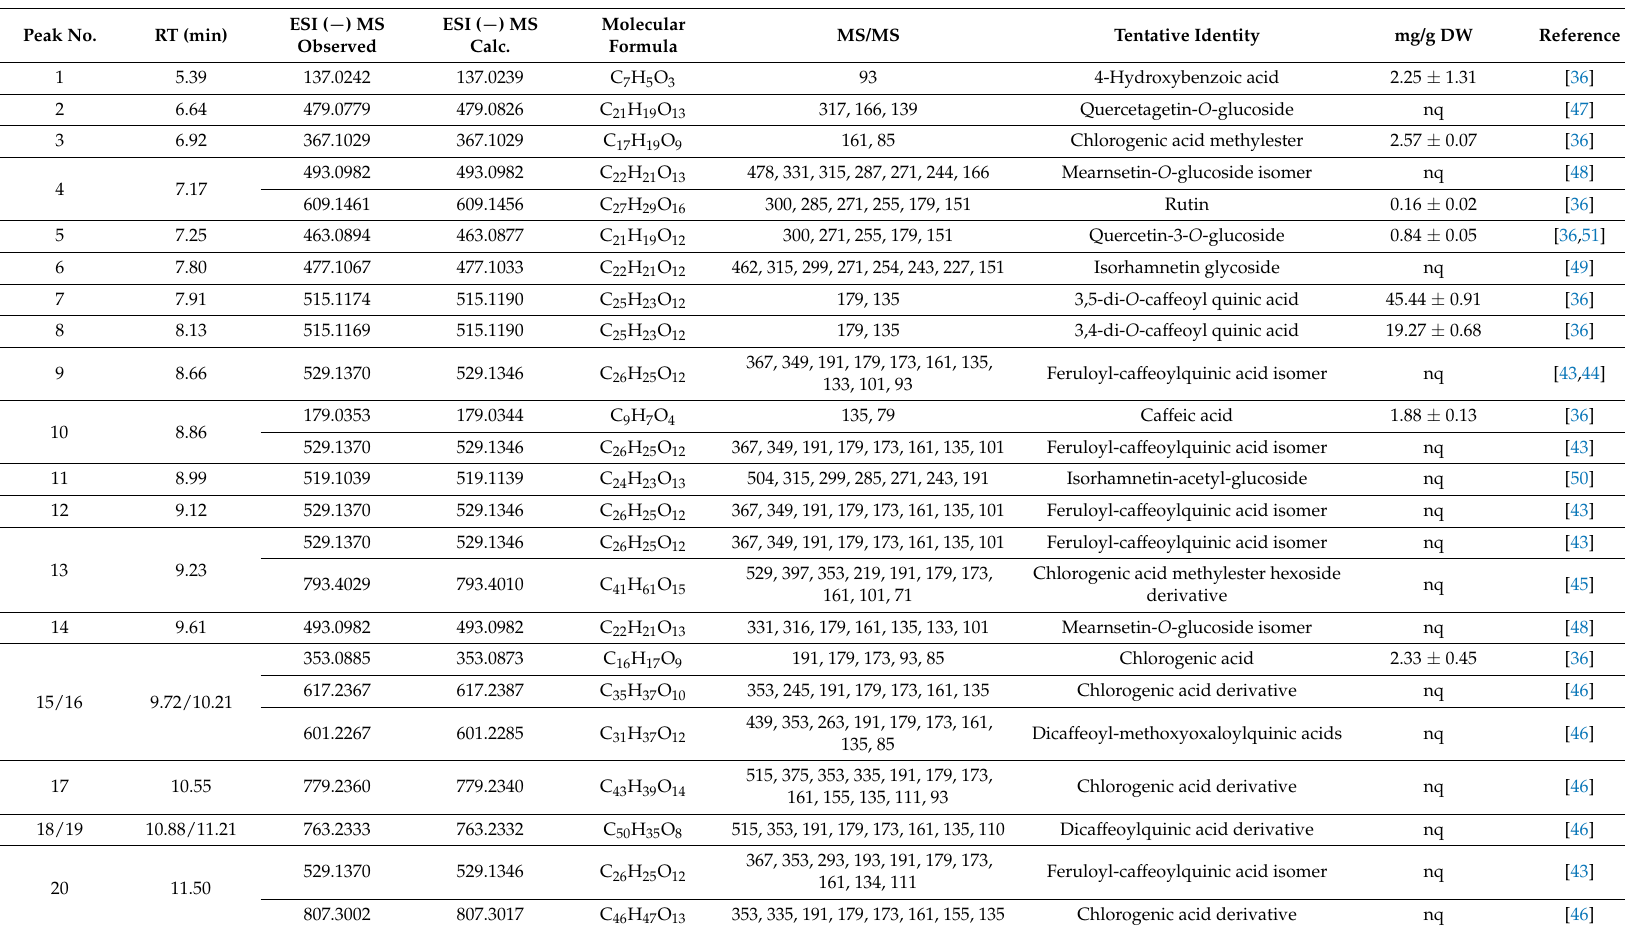
Table 3. Liquid chromatography-tandem mass spectrometry (LC-MS/MS) of ethyl acetate fraction of Senecio clivicolus . Identification of compounds based on m/z , and fragmentation pattern and retention time of standards. Quantities of the detected phenolic compounds were determined using commercial standards. Peak